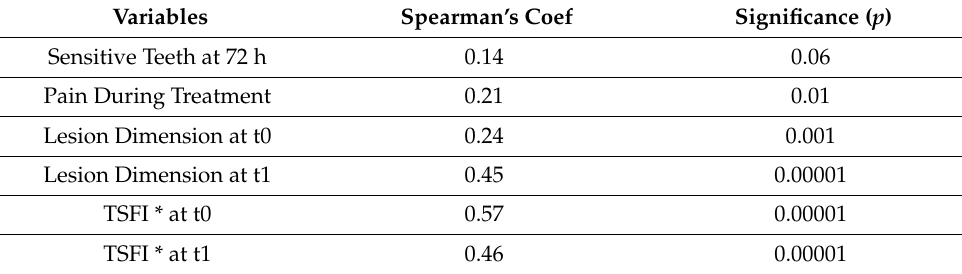
Table 3. Correlation between etching cycles and variables. Spearman’s correlation.